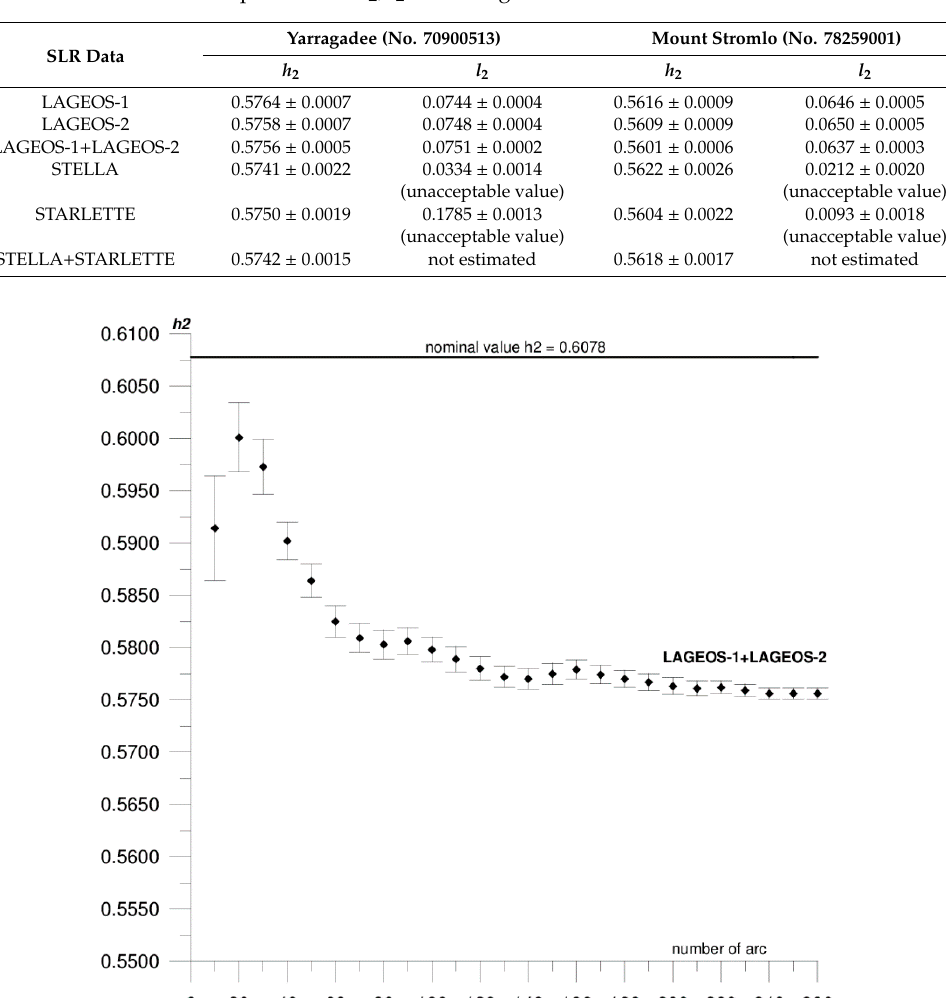
Figure 2. Sequential solution for the Yarragadee local h 2 parameter based on LAGEOS-1+LAGEOS-2 data.